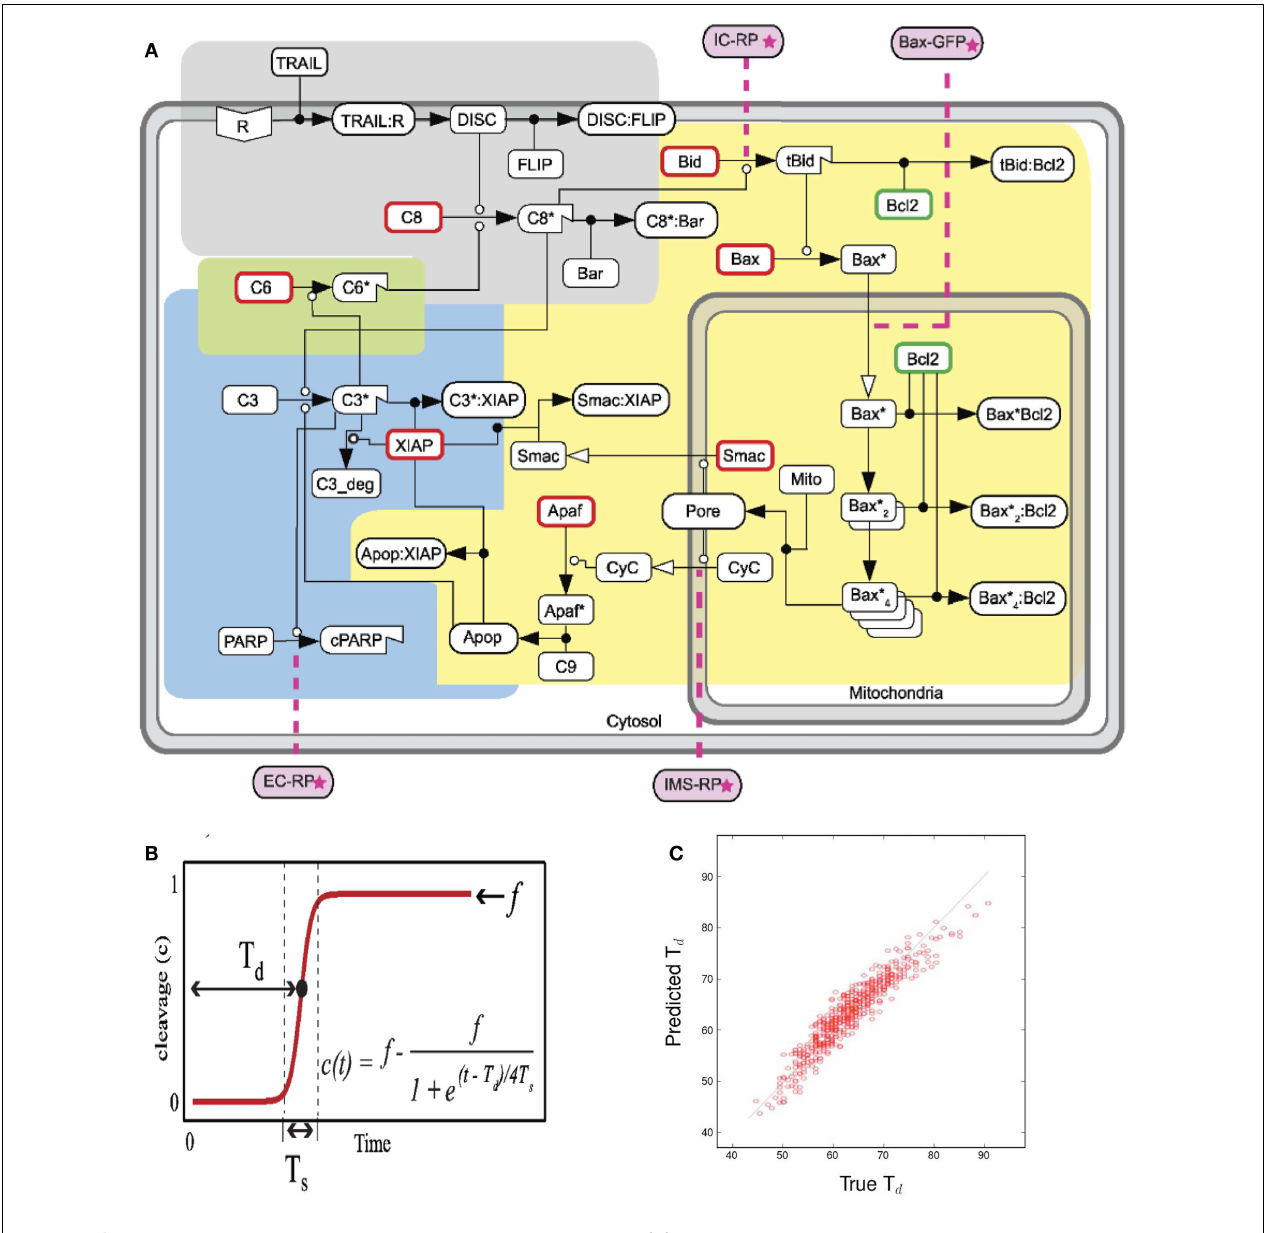
FIGURE 2 | Figures accompanying the sensitivity analysis . (A) Schematic of the extrinsic apoptosis reaction model. Each color represents a functional pathway. Adapted from Albeck et al. (2008).